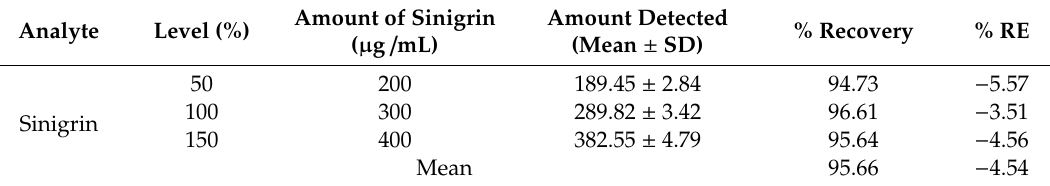
Table 3. Recovery study